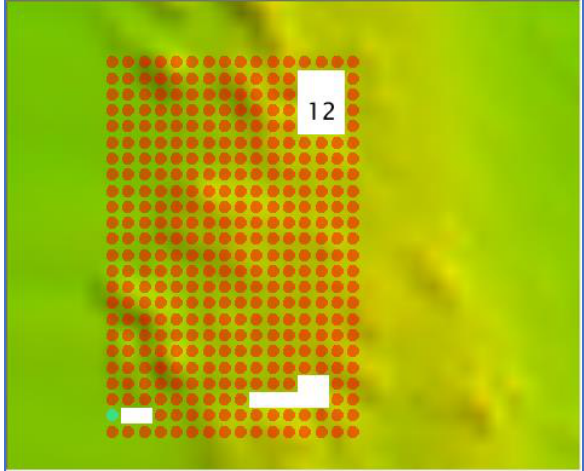
Figure 6. Outcomes from the Detect Holidays algorithm. The cells are marked with orange dots. The white areas are the grid gaps. Based on Full Coverage requirements, the gap of 12 grid nodes (black number) is marked as a holiday if it contains an instance of 3 × 3 unpopulated grid nodes [13] . The holes (white areas) with 7 nodes and 2 nodes do not fulfill such specifications.